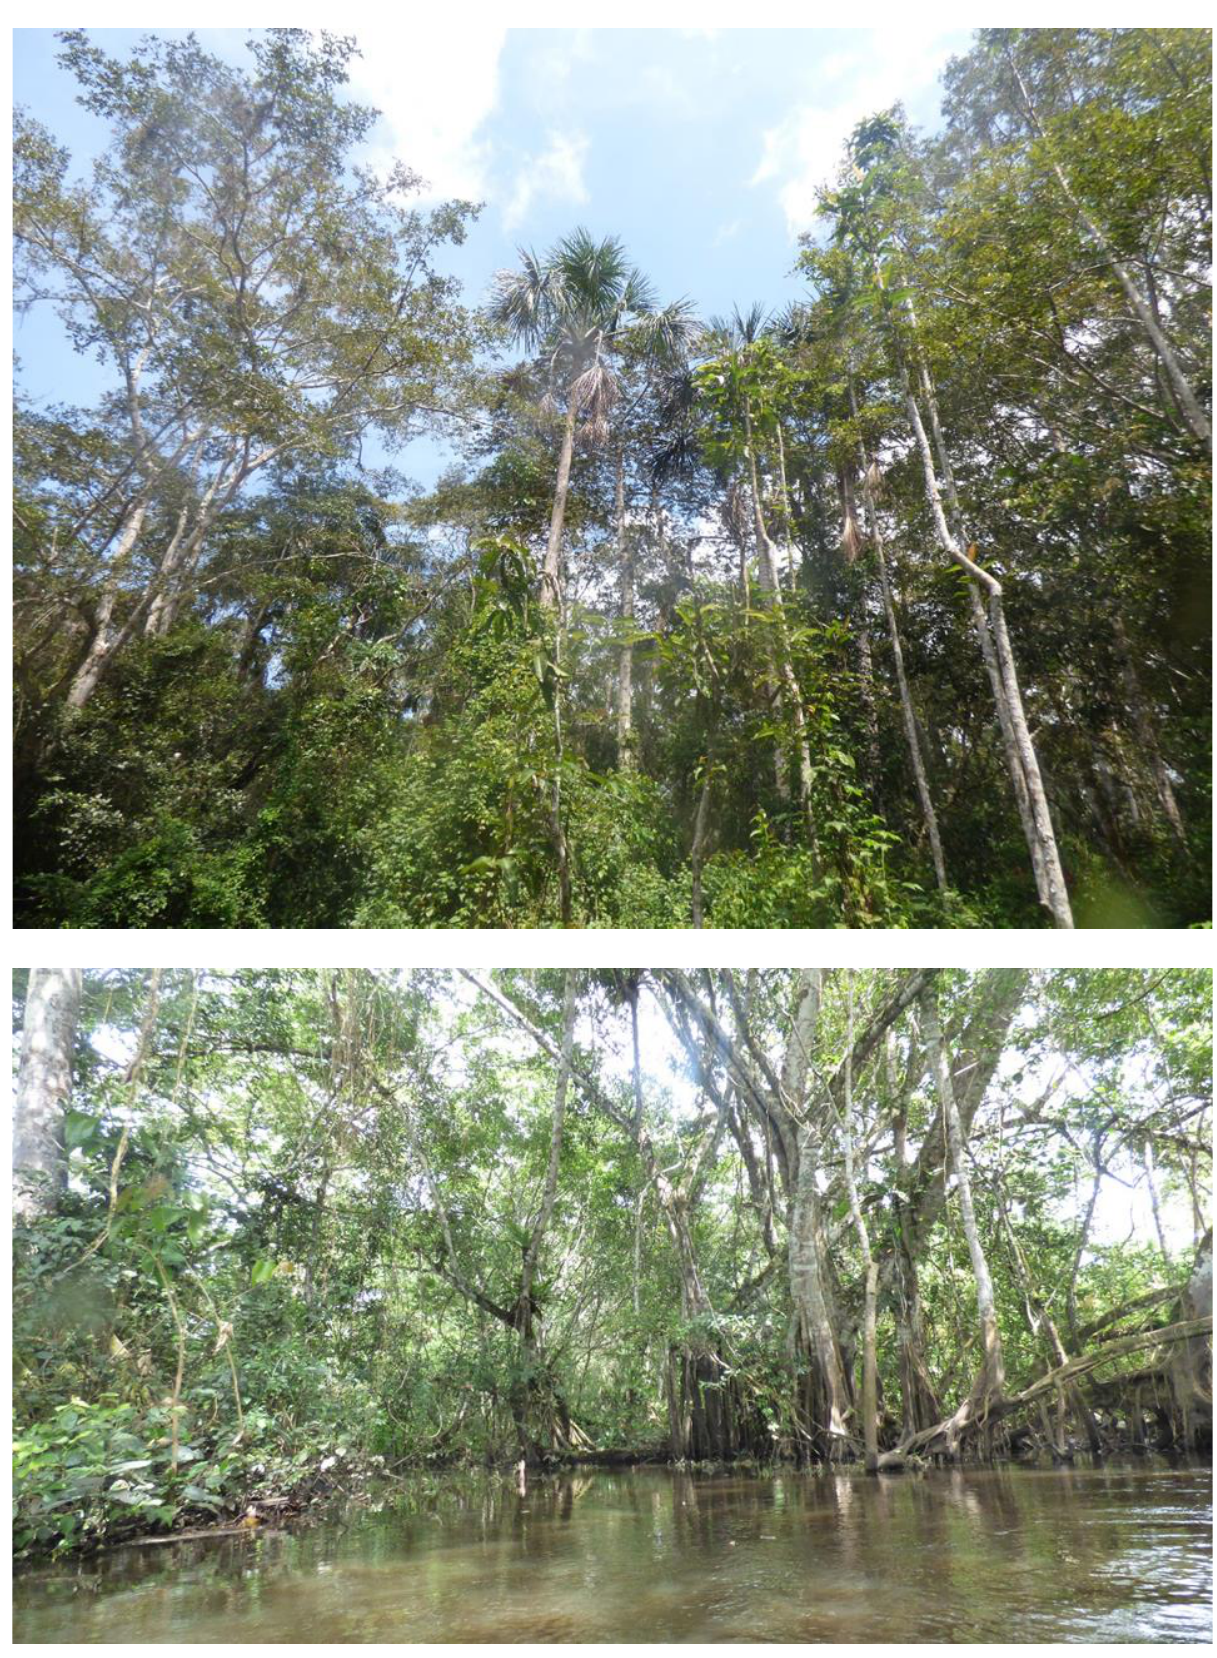
Figure 2. The two sampled swamp forests in ADECARAM, Tingana. Above: semi-dense swamp forest (SA); below: flood-prone area of mixed swamp forest